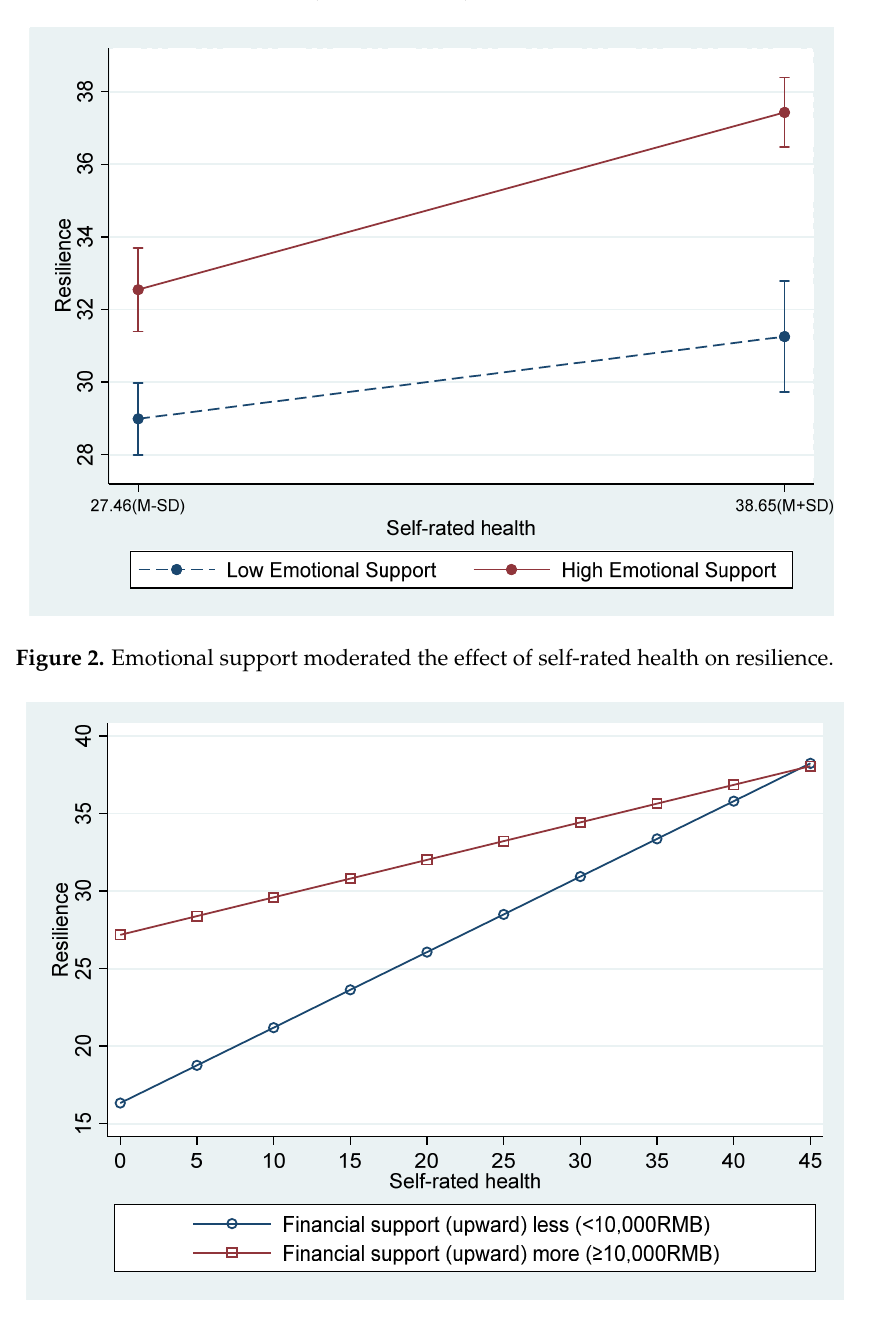
Figure 3. Financial support (upward) moderated the effect of self-rated health on resilience.